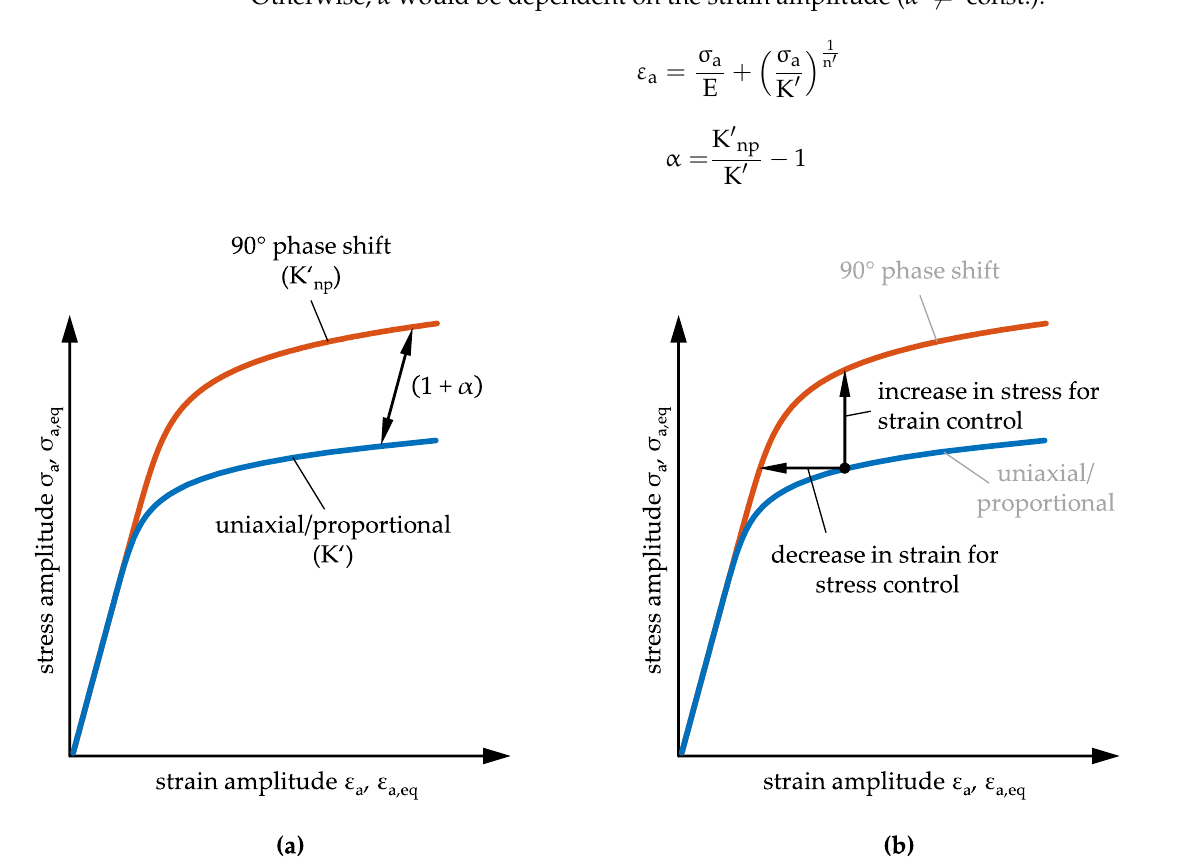
Figure 6. Nonproportional hardening expressed as ( a ) the difference between cyclic stress – strain curves for uniaxial or proportional and nonproportional loading with 90 ◦ phase shift and ( b ) the curves for uniaxial or proportional and nonproportional loading with 90° phase shift and ( b ) the effect on the resulting stress–strain amplitudes under nonproportional loading depending on the effect on the resulting stress – strain amplitudes under nonproportional loading depending on the type of type of control.